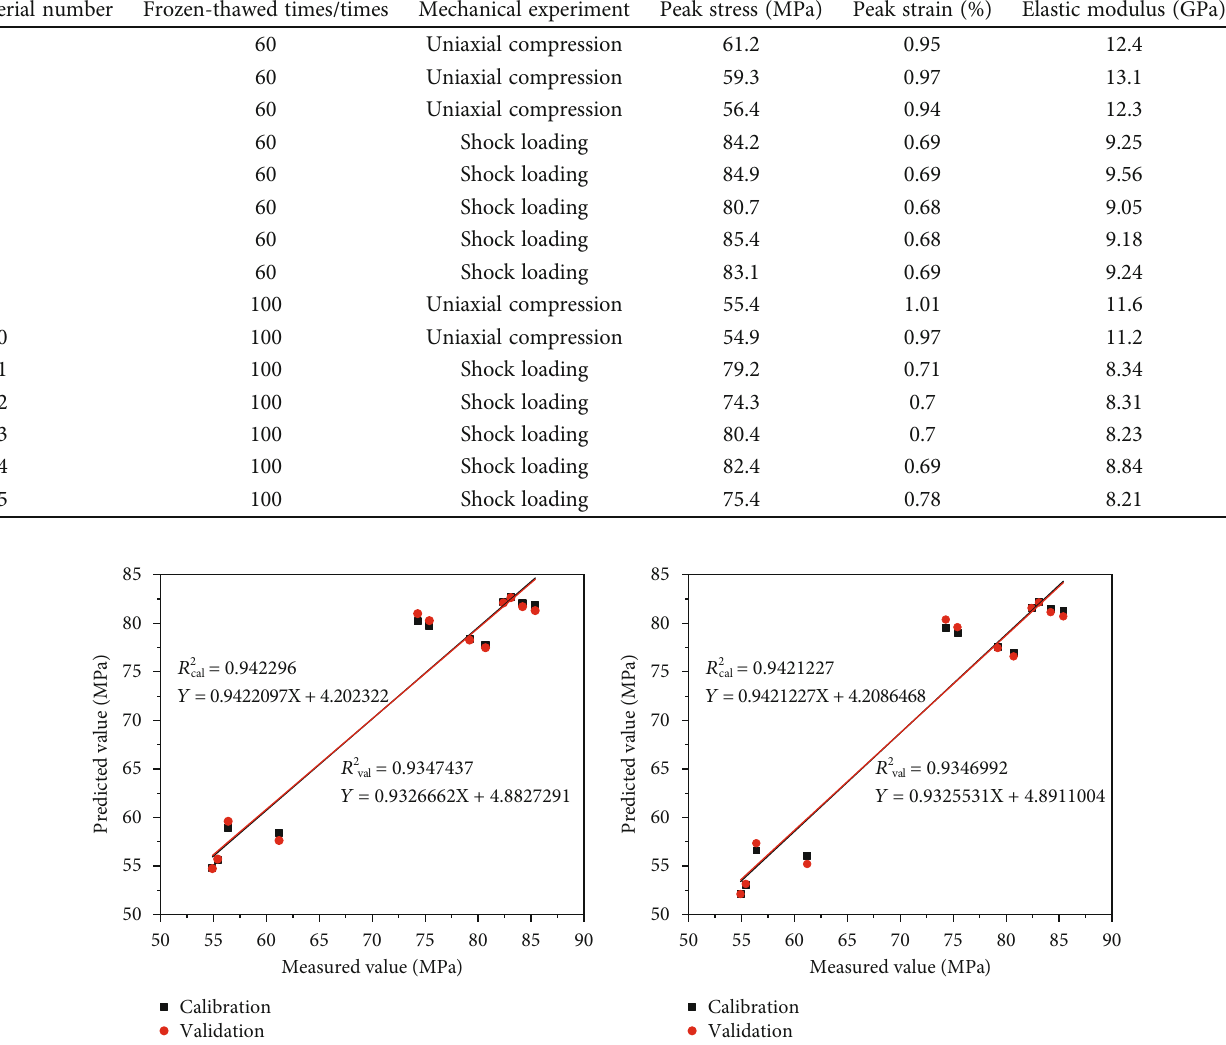
Table 1: Physical and mechanical parameters of surface rock samples.